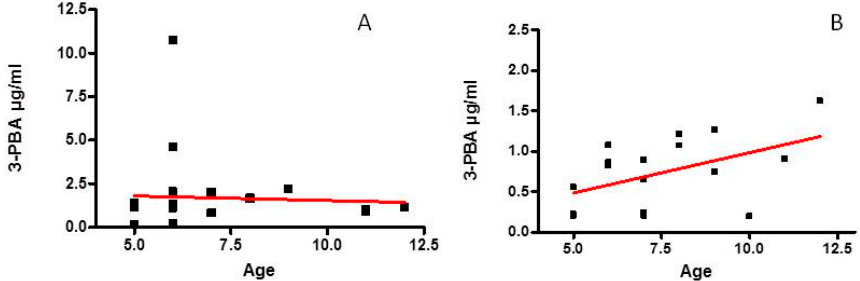
Figure 2. Relationship between age and of 3-PBA levels in urine of ASD ( A ) and CTR ( B ) children. Different scale was used because of different range of data.